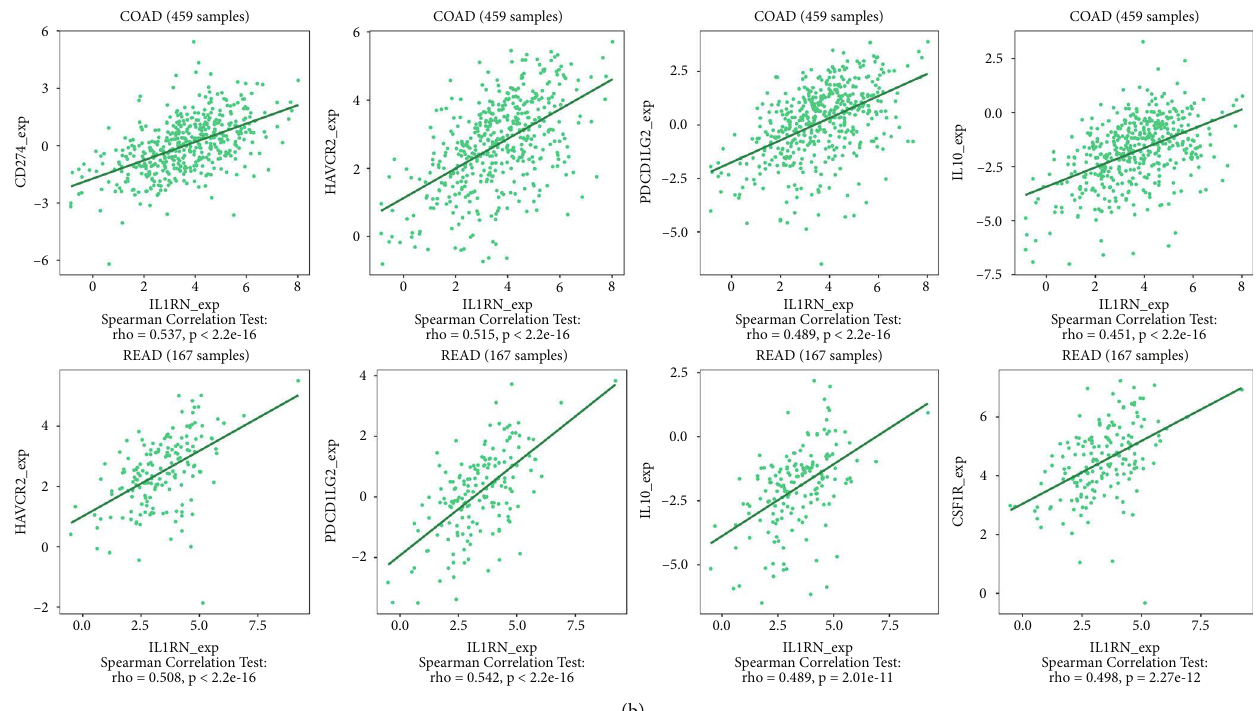
Figure 8: The expression of IL1RN is associated with immunomodulators in CRC. (a) Correlation between IL1RN expression and immunoinhibitors in CRC available at TISIDB database. (b) Correlation between IL1RN expression and immunostimulators in CRC available at TISIDB